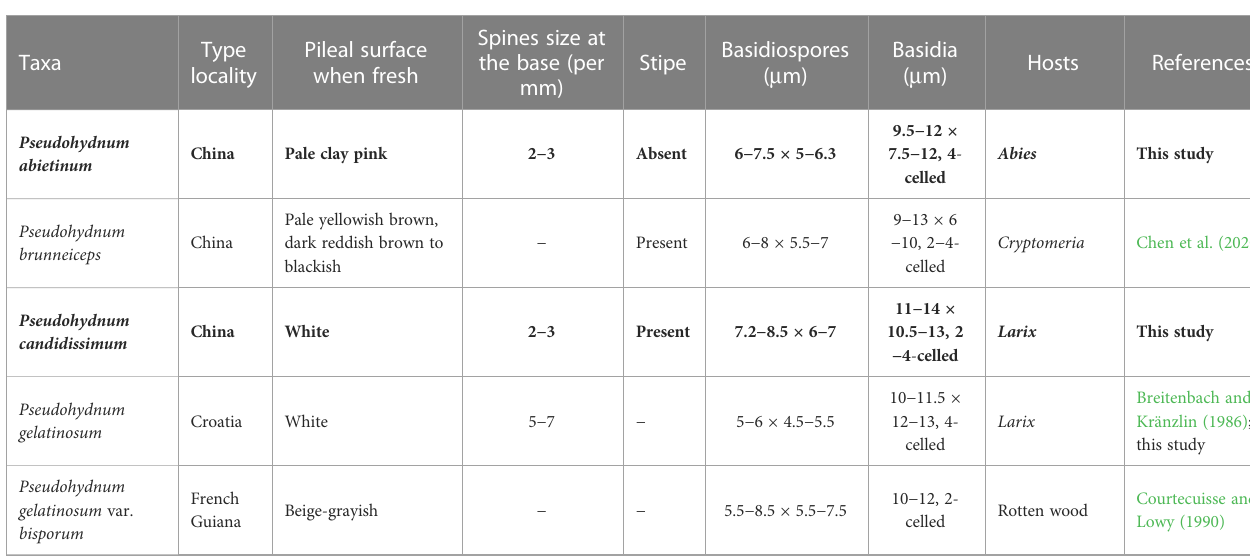
TABLE 2 A comparison of the morphologies, type localities, and hosts of Pseudohydnum